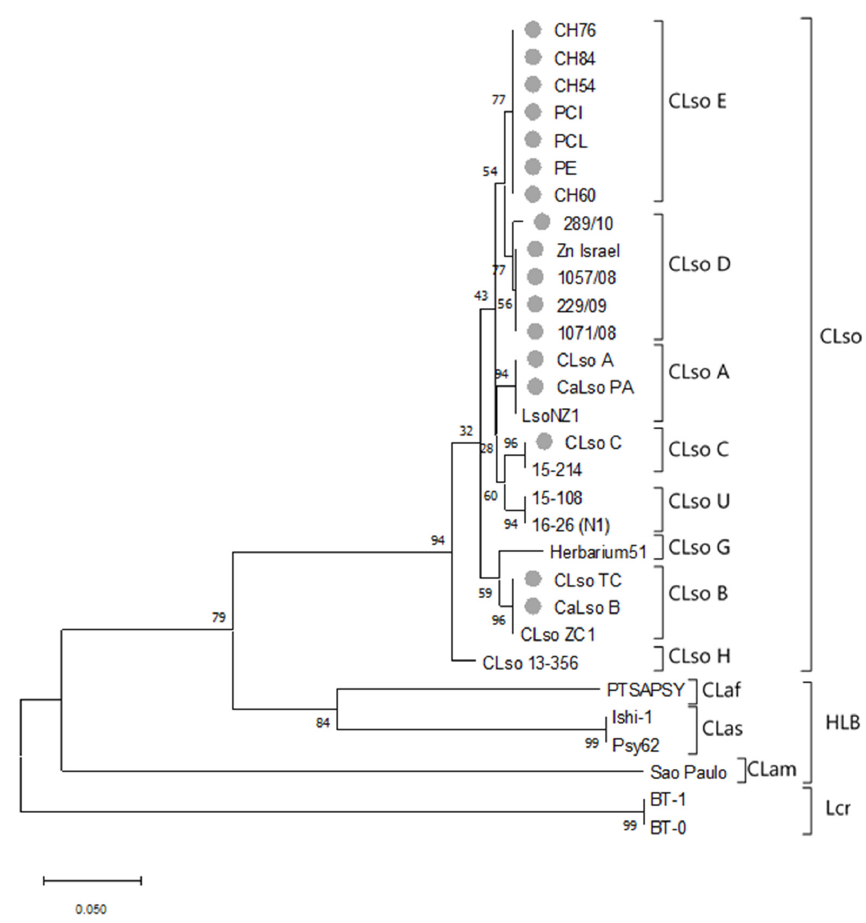
Figure 2. Example of phylogenetic tree of representative Liberibacter strains based on partial sequence of adenosine kinase gene ( adk ). The tree was based on nucleotide sequences from 30 isolates and 208 nt positions. Analysis was performed using the Maximum Likelihood method and the Tamura-Nei model [28]. Bootstrap values (1000 replications) are shown at the branch points. Grey circles indicate those sequenced in this work. Phylogenetic analyses were conducted in MEGA X [27].